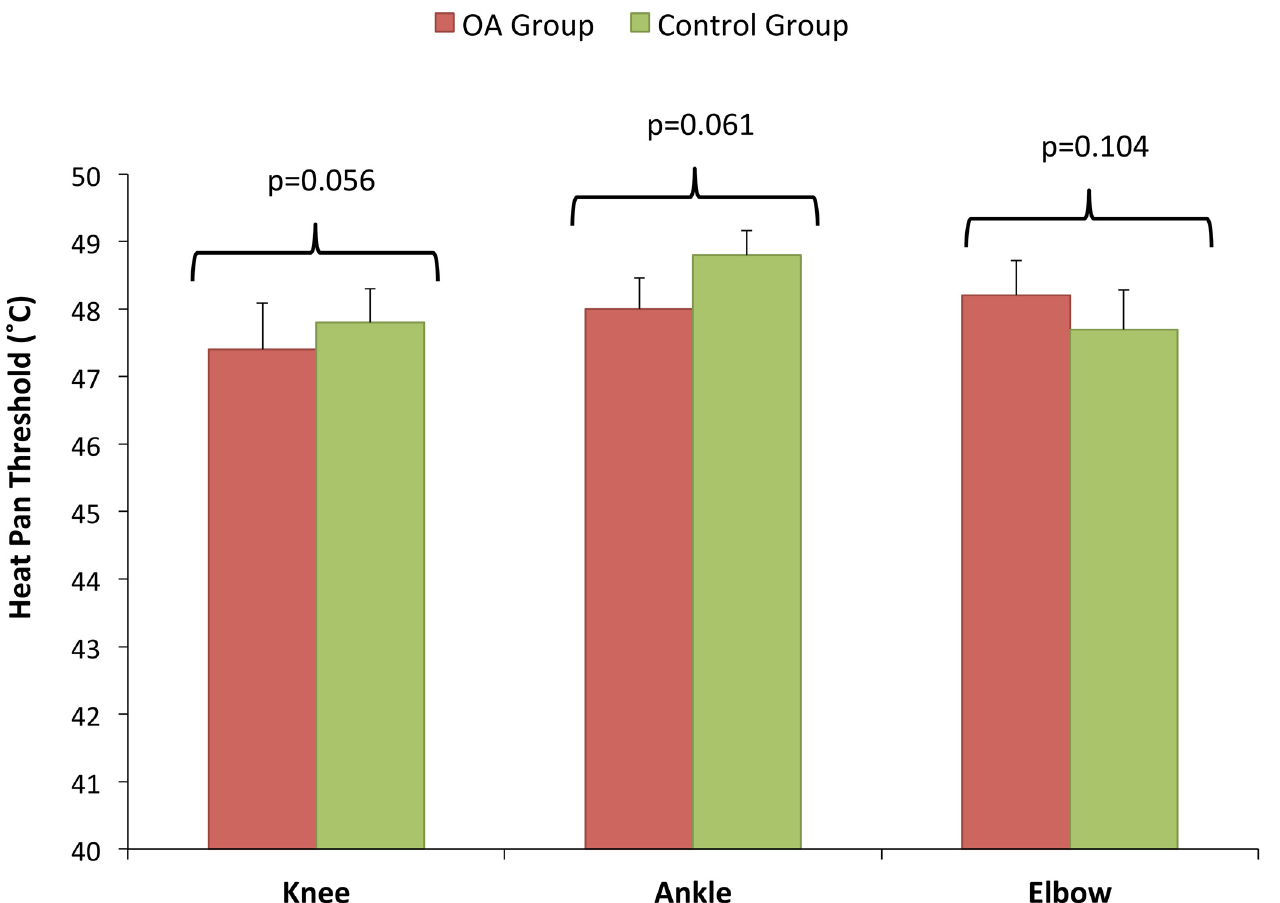
Fig 3. Heat Pain Threshold. There were no significant differences between OA and Control groups in heat pain thresholds. doi:10.1371/journal.pone.0147526.g003 PLOS ONE | DOI:10.1371/journal.pone.0147526 January 25,